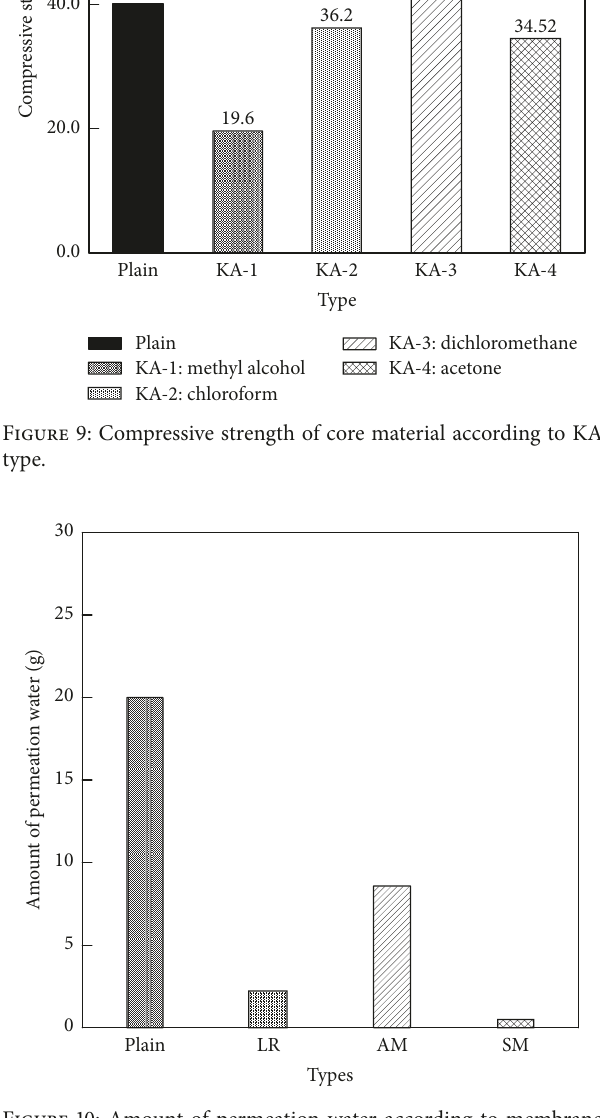
Figure 10: Amount of permeation water according to membrane material.